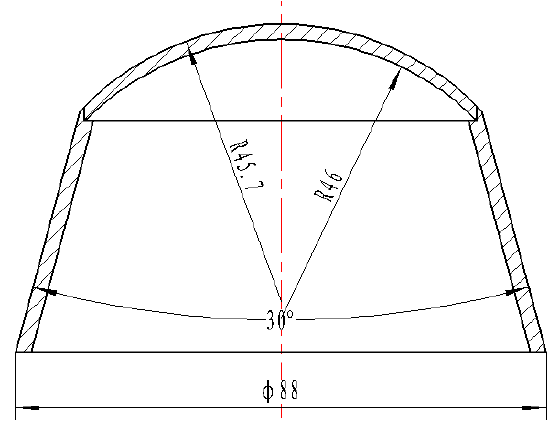
Figure 3. SCS liner.